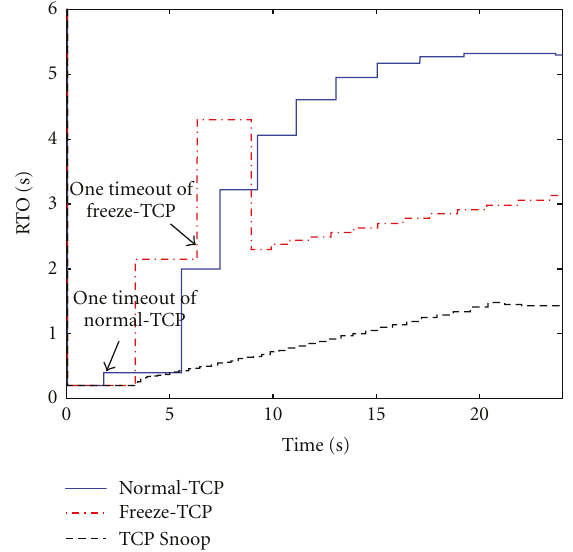
Figure 10: The variations of RTO value in TCP sender (UMTS data rate 64 Kb/s, local queue length 35 after